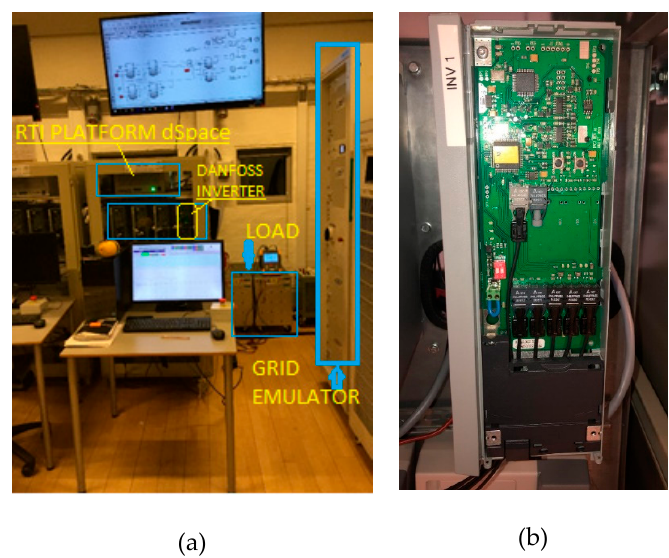
Figure 3. Experimental setup at the intelligent Microgrid Laboratory in Aalborg University (iML-AAU), Denmark: ( a ) Complete experimental setup; ( b ) detail of the Danfoss© single-phase inverter.